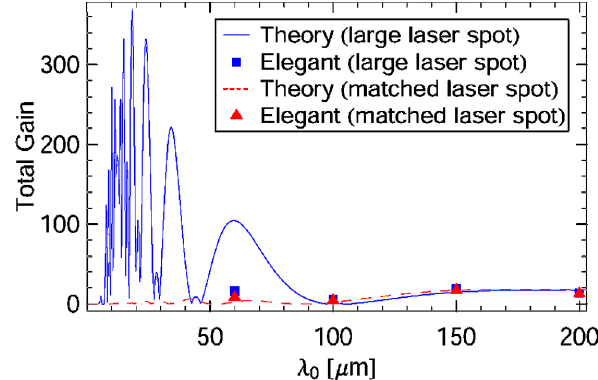
(red).FIG. 9. (Color) Microbunching gain after BC1 as a function of the initial modulation wavelength (cid:5) large laser spot (blue) and with a matched laser spot